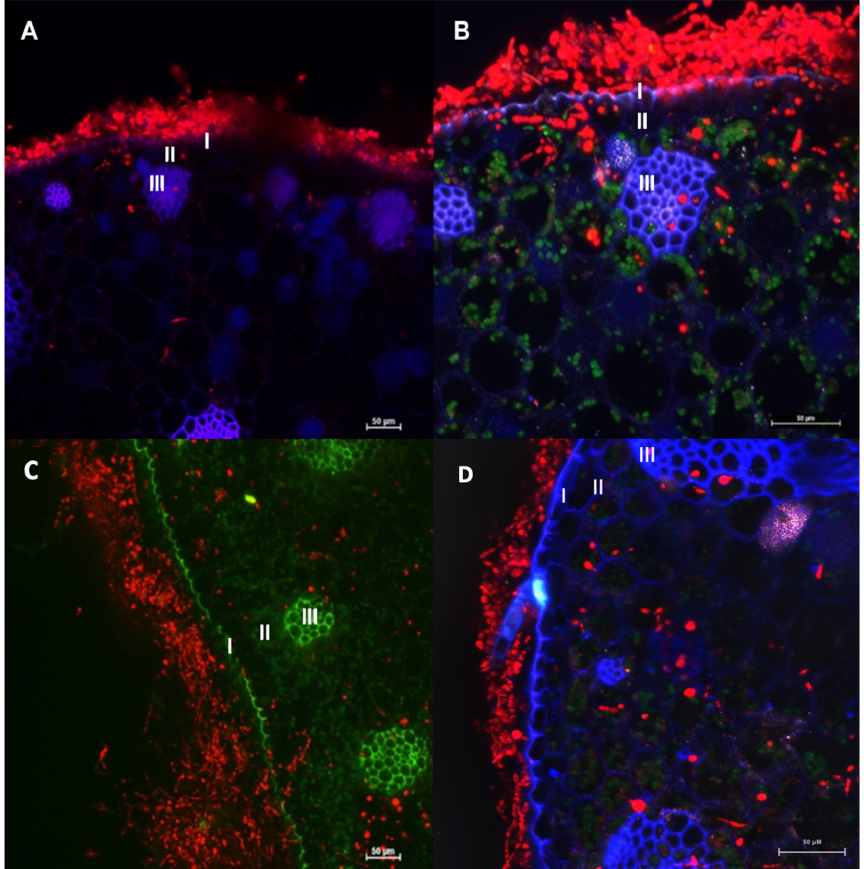
Figure 5. Confocal microscopy images of Bactris gasipaes plants inoculated with transformed Fonsecaea erecta ( A , B ) and Fonsecaea monophora ( C , D ) expressing DsRed gene (red fluorescence). Blue and green are autofluorescence of plant. It is possible to identify epidermis (I), parenchyma (II) and vascular tissue (III). Green autofluorescence reveals the chloroplasts in B and